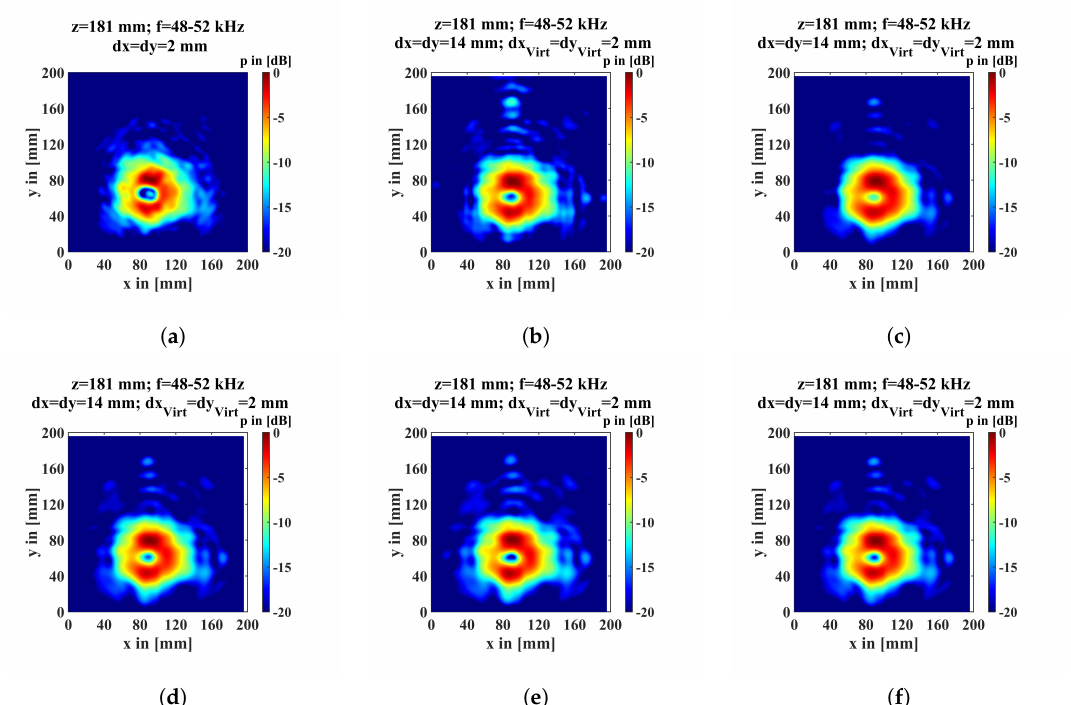
Figure 11. Back propagated amplitude at the top of the particleboard. ( a ) The “default” image measured with a 2 mm grid; the rest were measured with a 14 mm grid and refined to a 2 mm grid. ( b ) Interpolation method “nearest”. ( c ) Interpolation method “linear”. ( d ) Interpolation method “cubic”. ( e ) Interpolation method “spline”. ( f ) Interpolation method